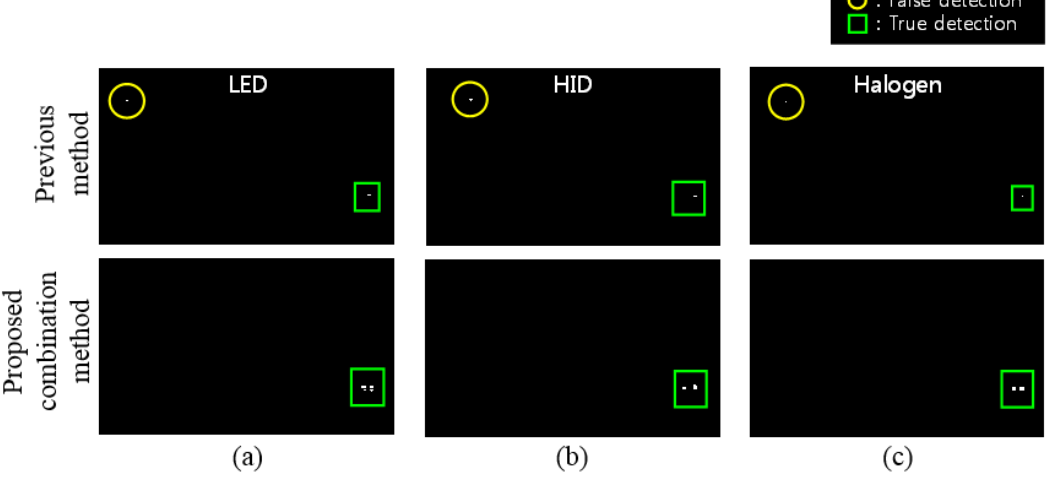
Figure 11. Comparison of the previous method [12] and with proposed method in ( a ) LED, ( b ) HID, ( c )